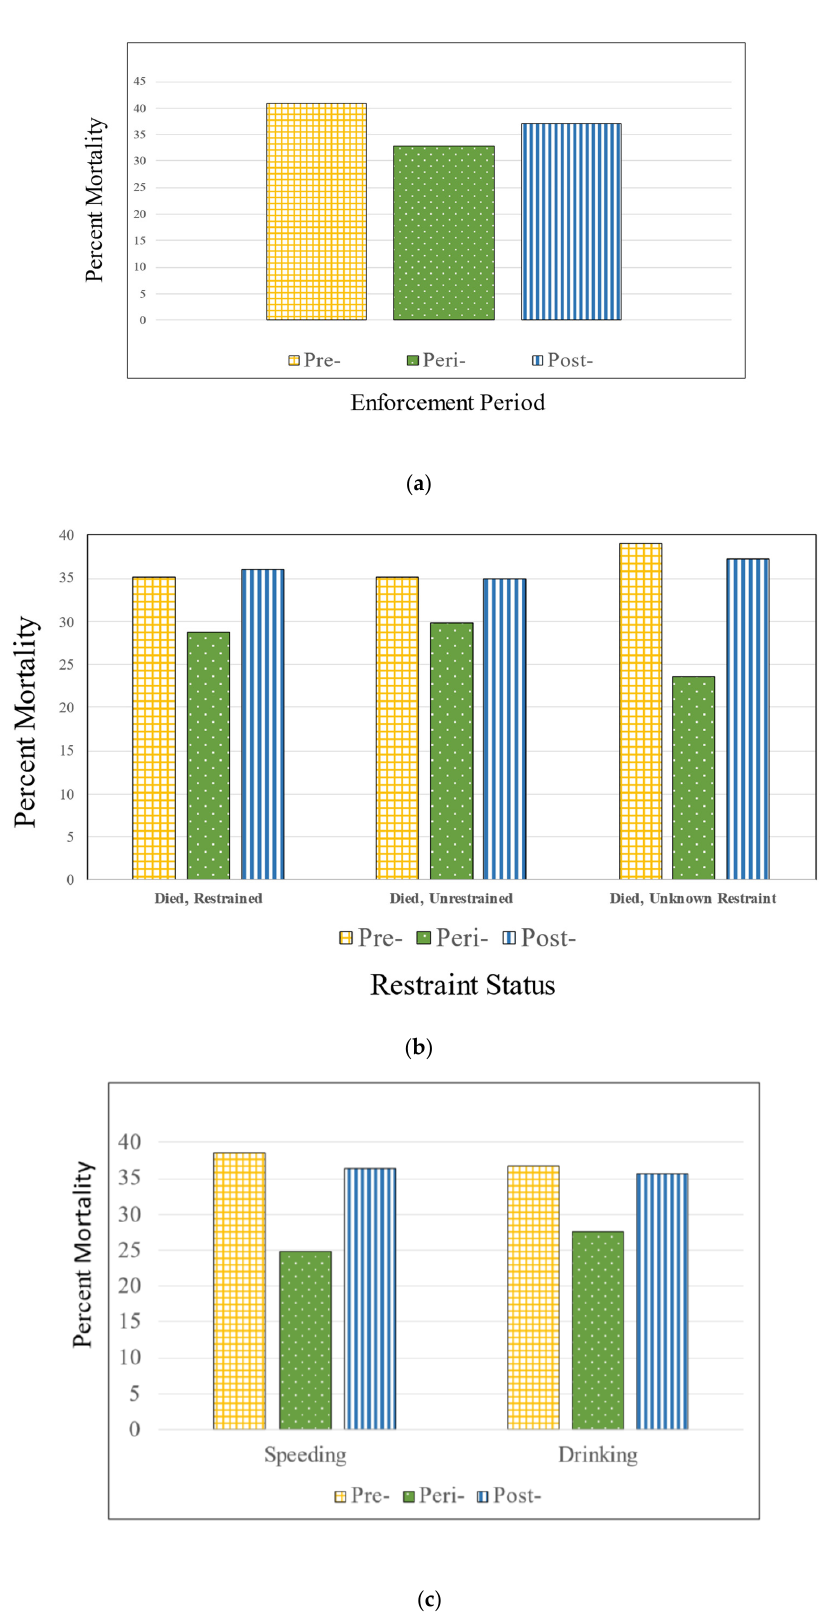
Figure 2. ( a ) Percent Mortality by High Visibility Click It or Ticket Enforcement Period. ( b ) Occupant Mortality by Restraint Status Period for Restrained, Unrestrained and Missing Restraint Status. ( c ) Proportion of Drivers in Fatal Crashes Who Were Speeding and/or Drinking by Enforcement Period. Mortality . Mortality was lower during the peri-enforcement period (32.9%) compared to pre-enforcement (40.9%) or post-enforcement (37.1%) (Table 1). Although mortality was highest in occupants in the lowest enforcement response areas (43.6%), this was not linear by level of enforcement strength as those in the medium response category had lower mortality than those in the high response areas (34.8% vs. 39.9%). Proportionally, fewer occupants died while being unrestrained during the peri-enforcement period than during either the pre-enforcement or post-enforcement timeframes. This was true across those who were restrained, unrestrained and missing restraint status (Figure 2b). Compared to the pre-enforcement period, fatal crashes involving speeding and alcohol were lower peri- and post-enforcement (Figure 2c). Mortality and vehicle characteristics . Mortality was higher in passenger cars (43.5%) than in SUVs, vans or pickup trucks. Mortality decreased nearly linearly by increasing vehicle model year, from 53.9% for models older than 1994 to 26.1% for models 2015 or newer. Urban/rural status . Mortality was significantly higher in rural crashes than in urban crashes with more than half (55.4%) of the study population with known urban/rural crash status being involved in a rural crash (not shown). There was no difference in the distri- bution of urban vs. rural crash locations across study periods. Time of day and day of week . There were significantly fewer nighttime fatal crashes during the peri-enforcement period compared to either pre- or post-enforcement ( p < 0.0001) (Table 2). There were no differences in weekday vs. weekend fatal crashes across study periods. Mortality was only slightly higher at night and was lower on weekends than weekdays (Table 2).